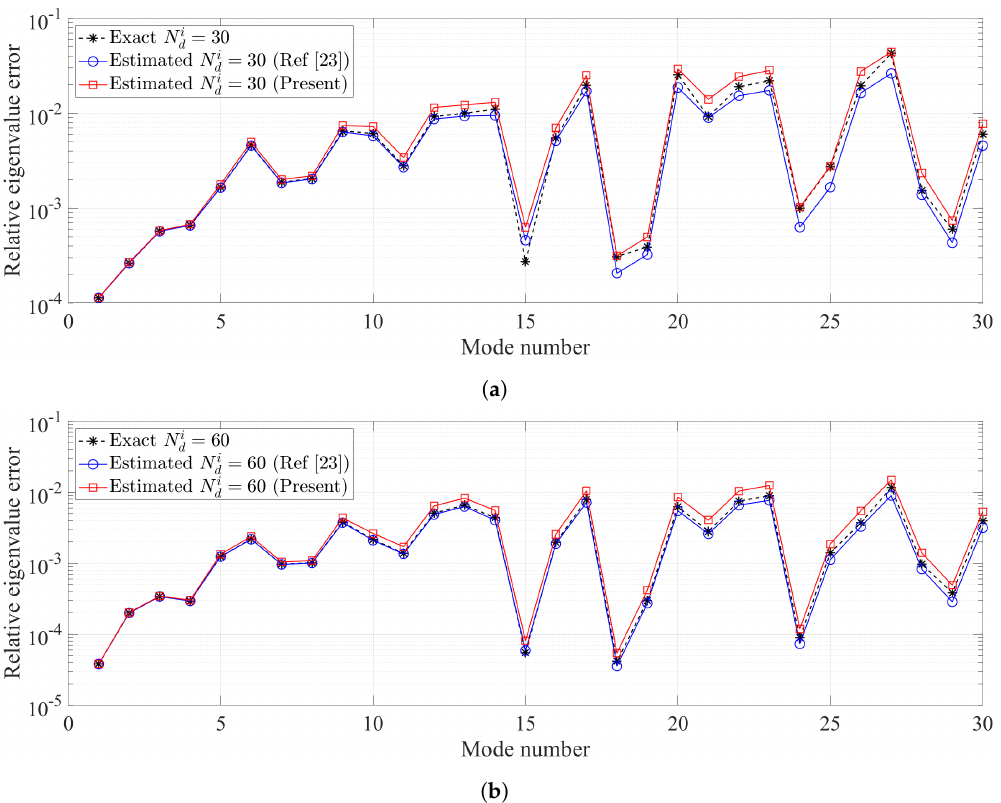
Figure 13. Comparison of the error estimator from the previous work [23] and the new error estimator derived in Equation (43). The new error estimator gives the upper bound results for the different numbers of dominant modes N i